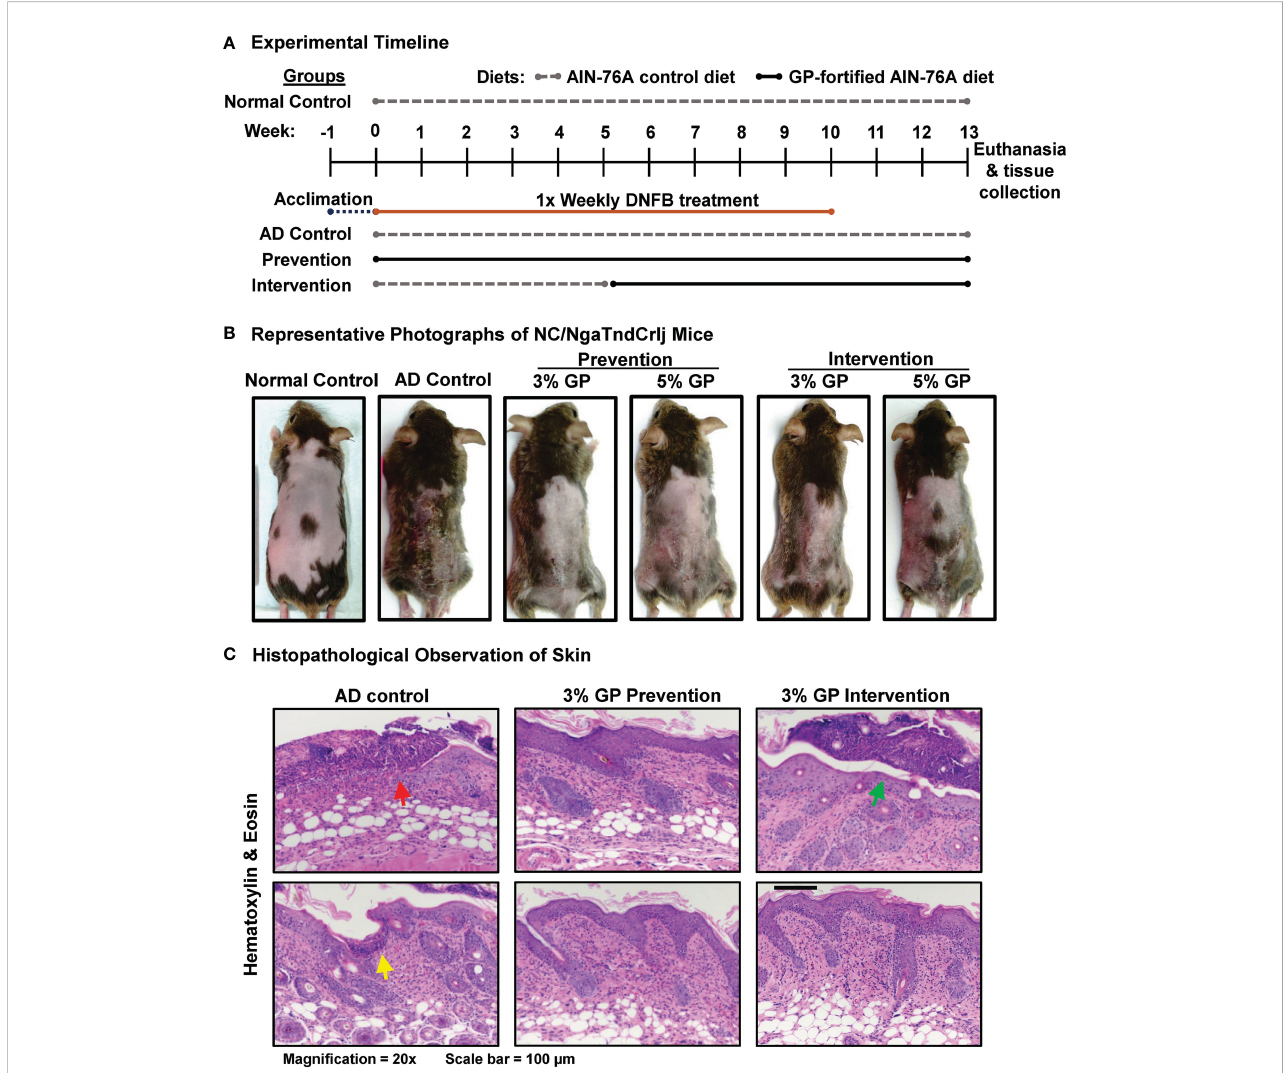
FIGURE 1 Effect of grape powder supplementation against DNFB-induced atopic dermatitis in NC/NgaTndCrlj mice. (A) Timeline and experimental design of DNFB-induced AD in NC/NgaTndCrlj mice, and prevention and intervention trials with 3% and 5% GP. (B) Representative images of mice from each experimental group immediately before euthanasia, demonstrating the severity of AD-like skin lesions across all groups. (C) AD histopathological analysis in skin sections was performed as described in ‘ Materials and Methods ’ section. At least fi ve images were taken at 20x magni fi cation across fi ve different skin sections of each mouse. Representative images are